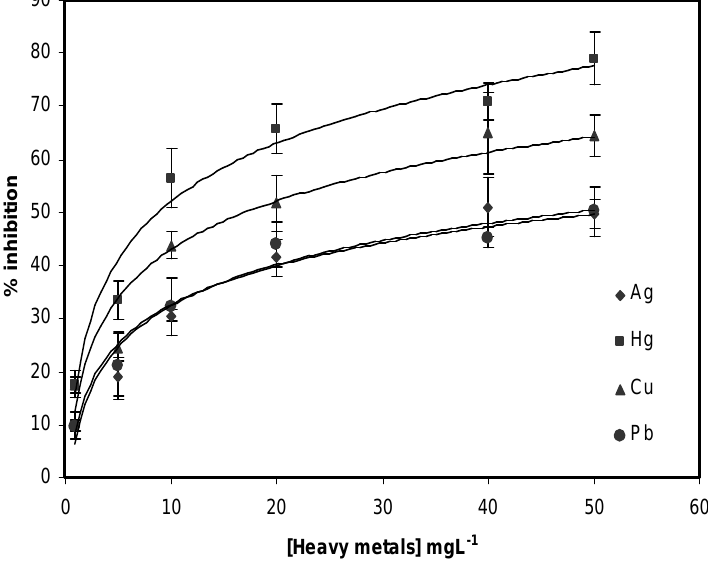
Figure 7. The profiles of inhibition of the biosensor response by several metal ions at 120 µM of AA2P substrate in 0.1 M tris-HCl buffer, pH=8.5, applied potential 0.6 V versus O nanoparticles immobilized was 0.4 Ag/AgCl reference. Fe 3 4